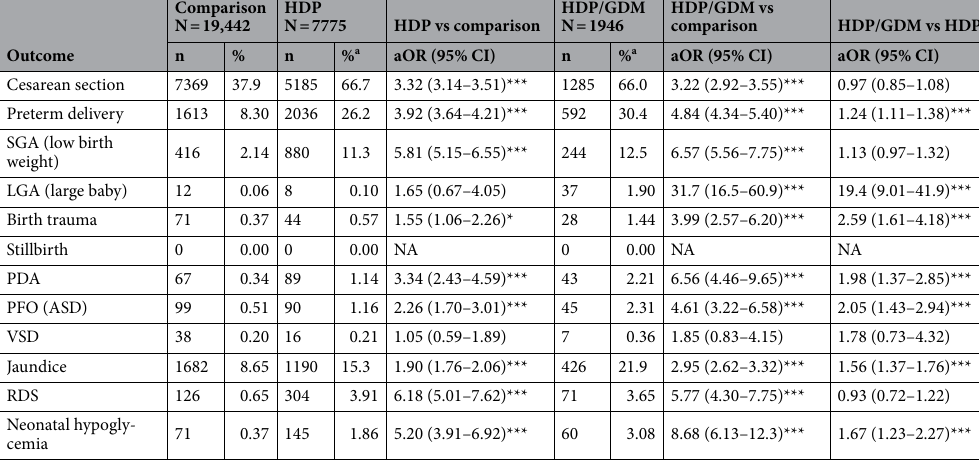
Table 2. Adjusted odds ratio (aOR) and 95% confidence interval (CI) of pregnancy outcomes in HDP women with and without GDM. HDP: hypertension during pregnancy without gestational diabetes mellitus; GDM: gestational diabetes mellitus; aOR: adjusted odds ratio controlling for demographic factors and baseline comorbidities; PDA, patent ductus arteriosus; PFO, foramen ovale/atrial septal defect; VSD, ventricular septal defect; RDS, respiratory distress syndrome. *p < 0.05, **p < 0.01, ***p < 0.001. a The sum over 100% due to cases with more than one